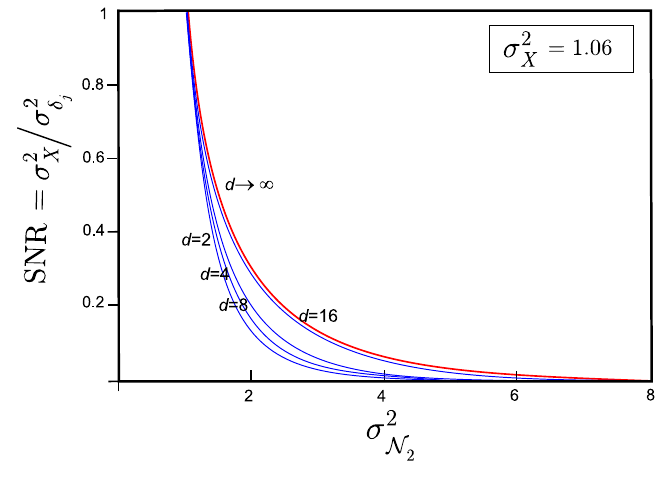
Figure 7. The SNRs of the logical channel at variance 2 1.06 X s = . As the dimension increases the variance of the logical channel reaches the variance of the physical quantum channel. At d = 16 the variances perfectly coincidence.